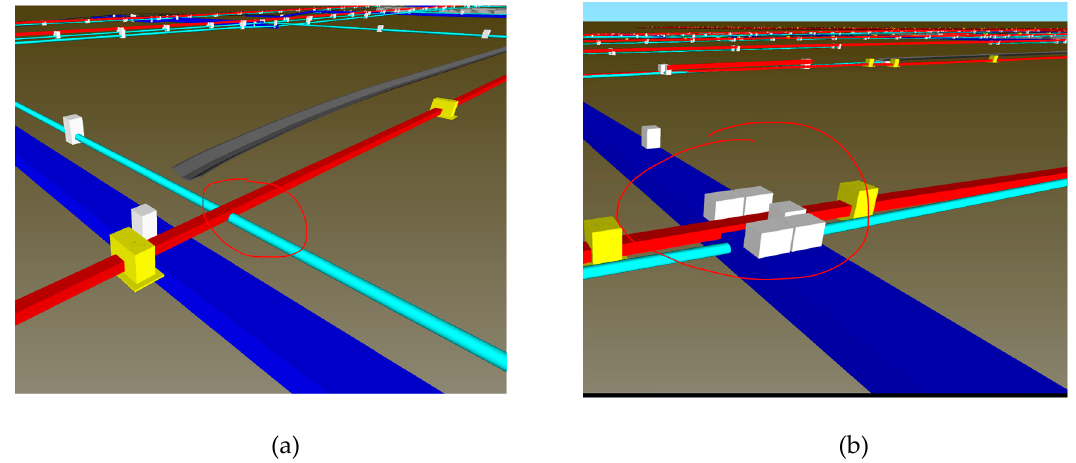
Figure 5. Clashes between the AGL, pipe and culvert models. ( a ) Clash between the AGL and pipe models; ( b )Clash between the AGL and culvert models. Red: AGL, Cyan: Pipe, Dark Blue: Culvert